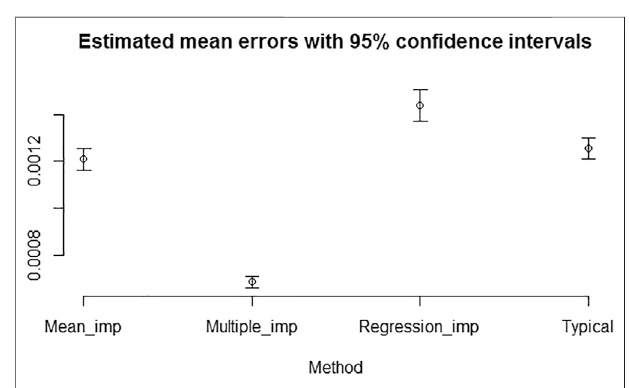
FIGURE 3 | Estimated mean errors with 95% con fi dence intervals for computing Brier scores with 10% overall missing values introduced completely at random.